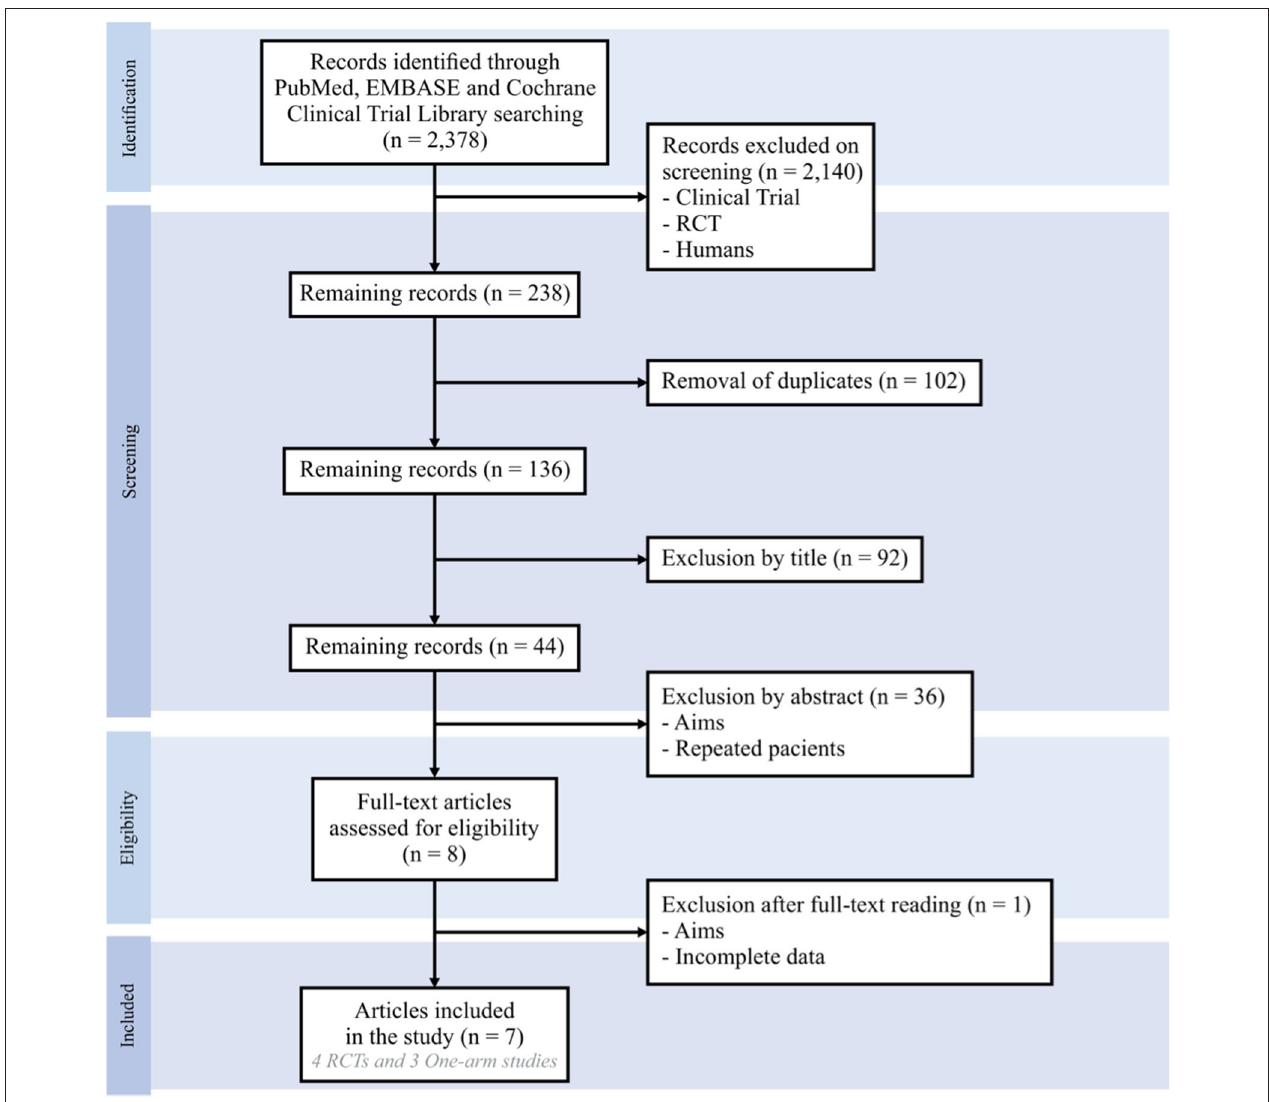
FIGURE 1 | A study